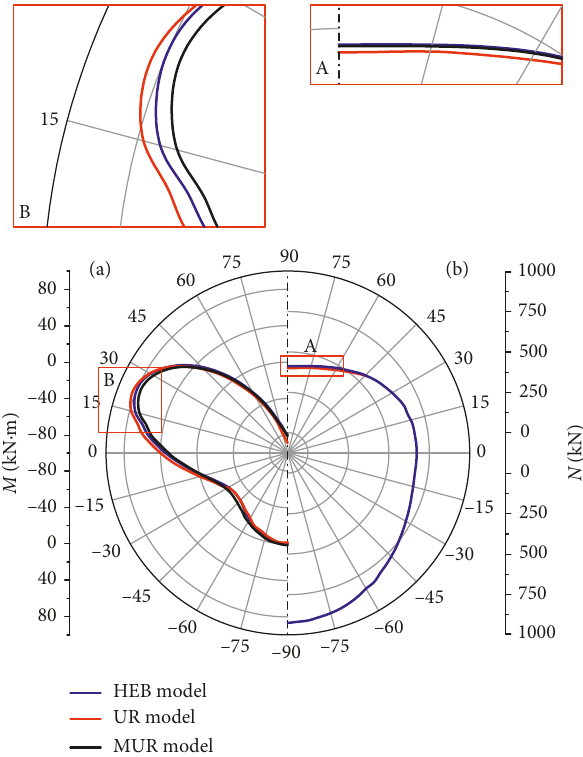
Figure 13: Calculation results by three models. (a) Bending moment. (b) Axial